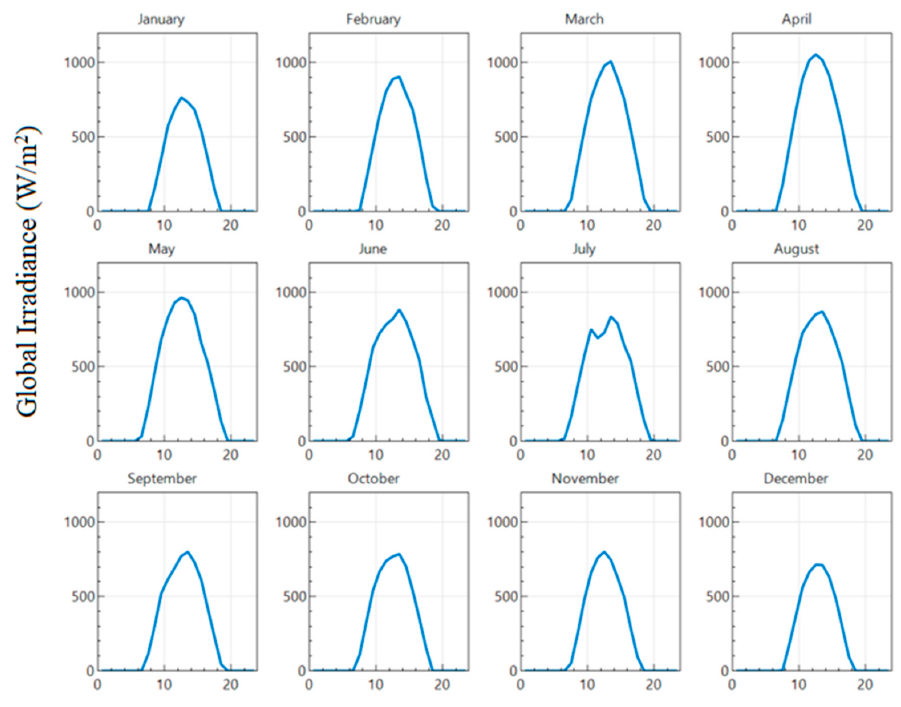
Figure 9. Average solar irradiation in Central Mexico.